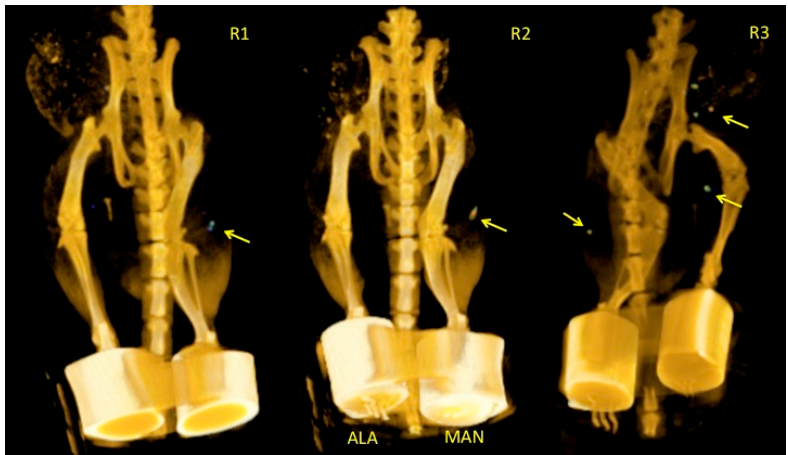
Figure 5. Micro single-photon emission computed tomography (SPECT)/computed tomography (CT) images depicting AuNPs-MAN 48h vs. AuNPs-ALA 48h accumulation in the popliteal lymph node. Arrows indicate the location of the nodes. ALA and MAN notation indicates the injection of AuNPs-ALA 48h and AuNPs-MAN 48h in the left and right footpad, respectively. Animals were oriented in a prone position.